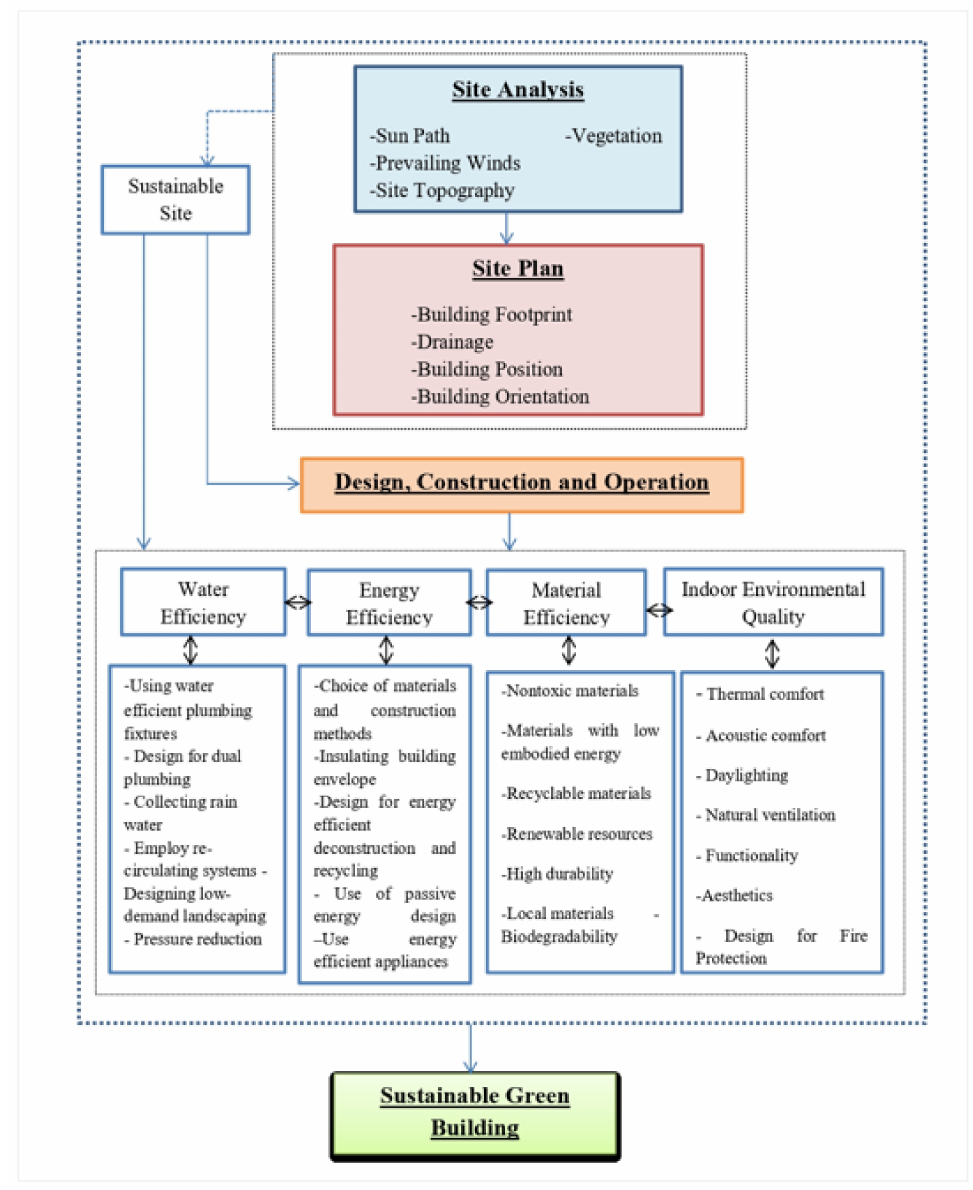
Figure 6. Framework for adopting the concepts and technologies of green